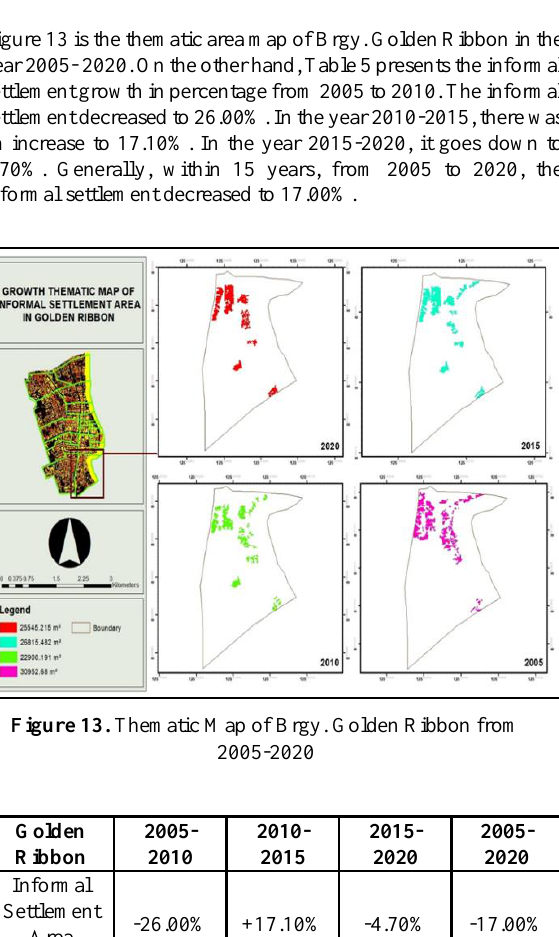
Table 4. Informal Settlement Growth in Percentage in Brgy. New Society Village